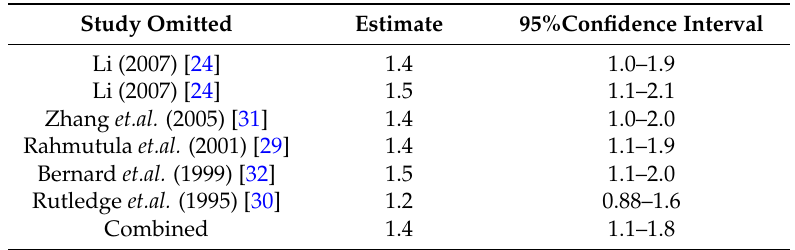
Table 6. Sensitivity analysis of G1837A polymorphism and EH (GA vs. GG).